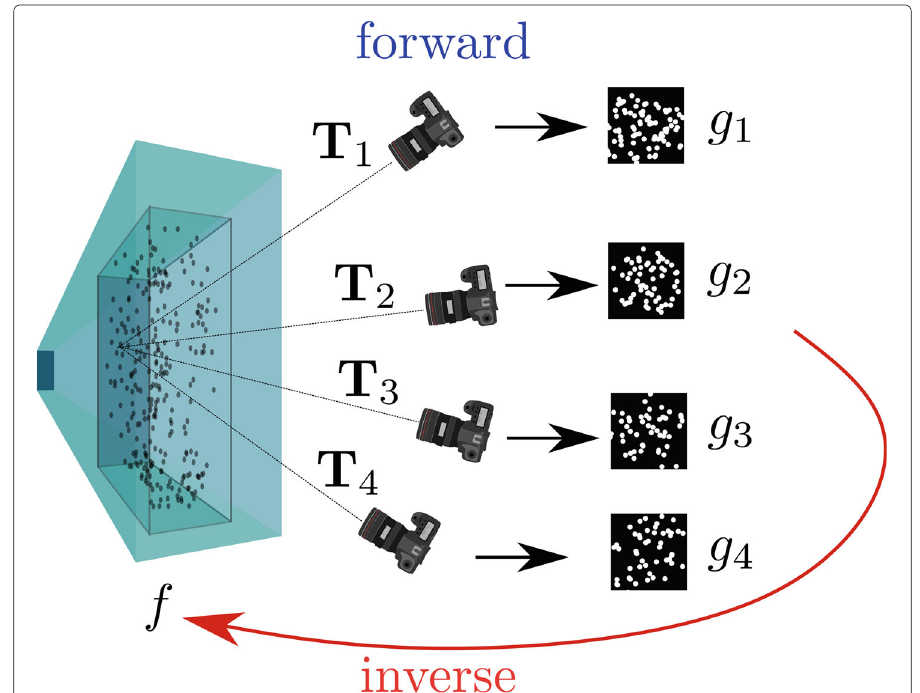
Fig. 1 Illustration of particle reconstruction as an inverse